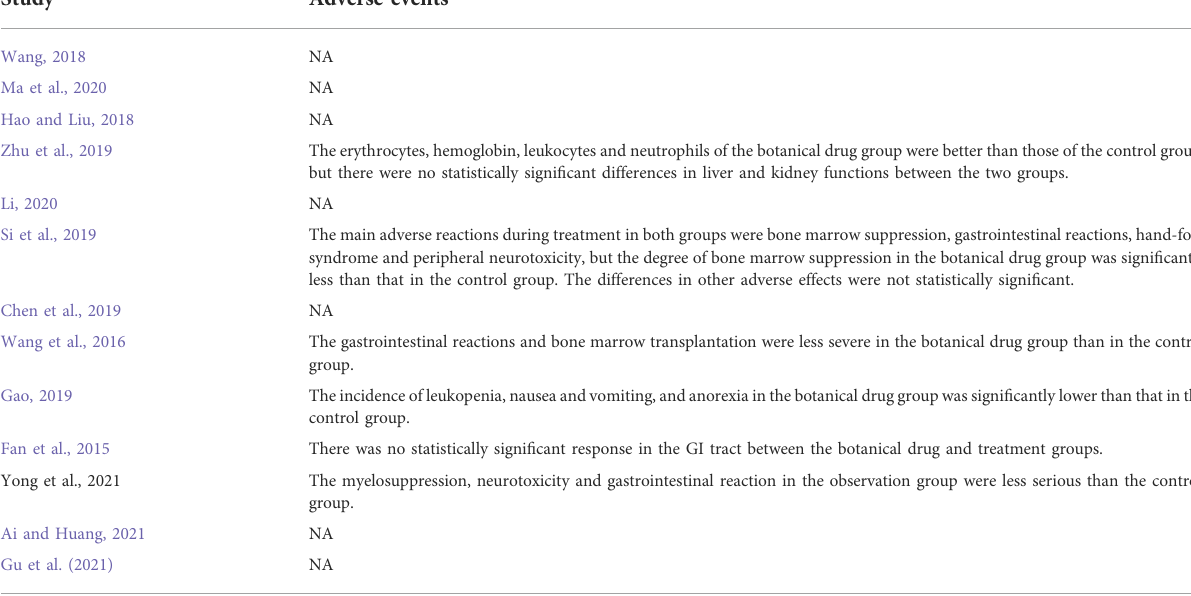
TABLE 2 Adverse events reported in the included